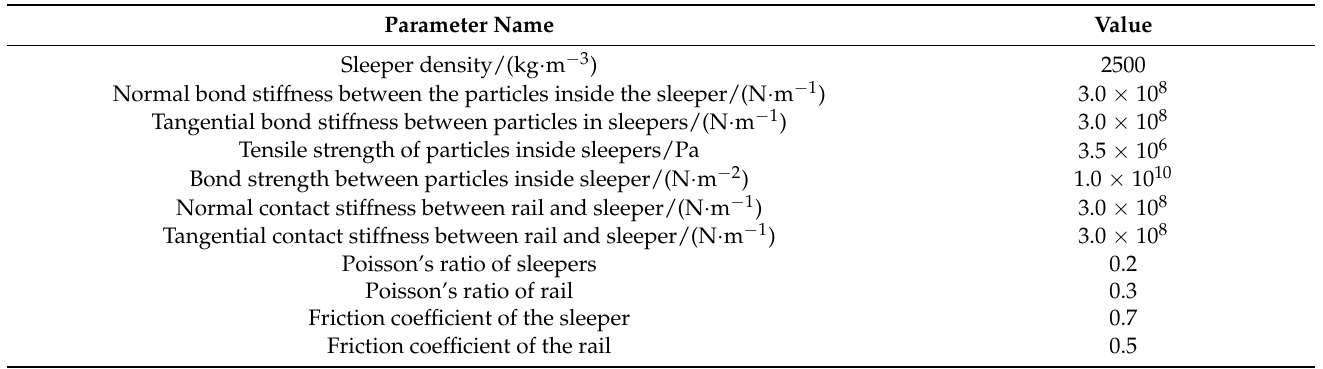
Table 1. Micromechanical parameters of the discrete element